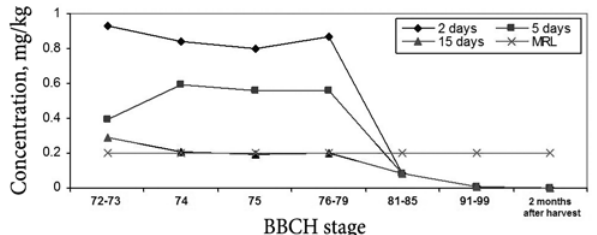
Fig. 16. Degradation of deltamethrin in Jonathan apples